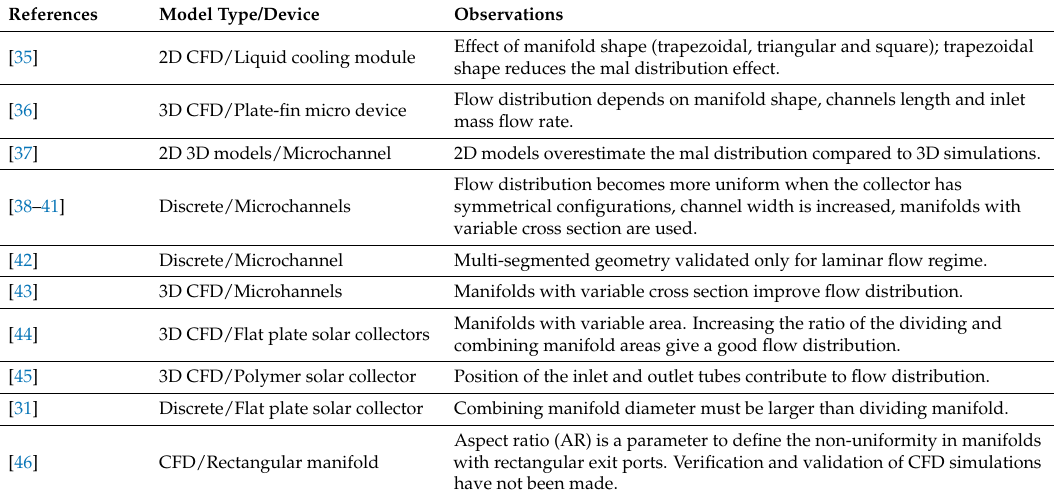
Table 2. Strategies used in thermal